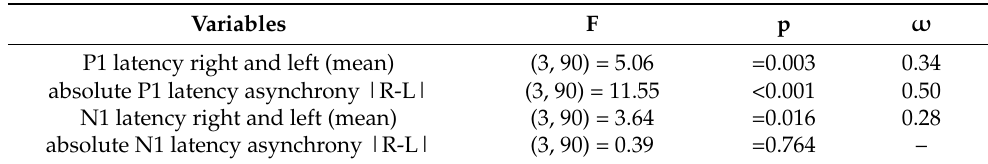
Table 5. ANOVA results of the four MEG variables. Variables F